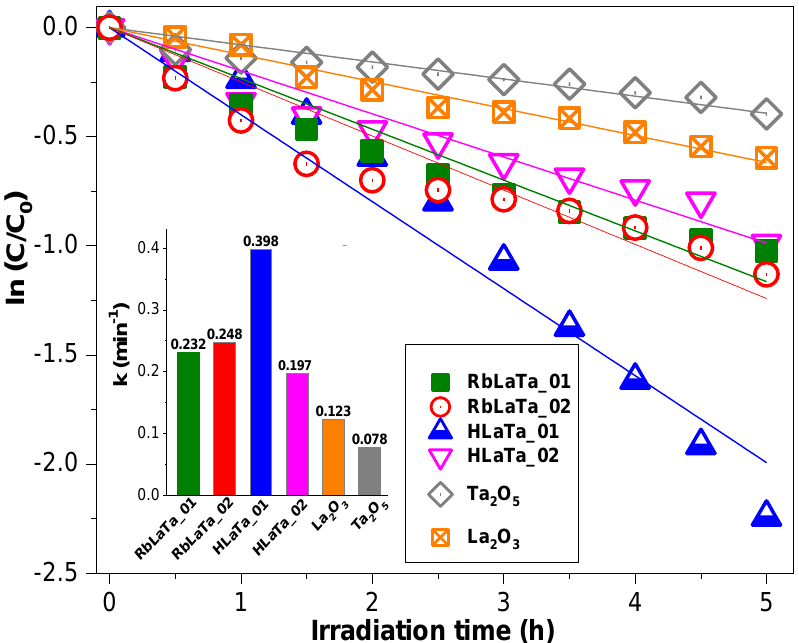
Figure 11. Pseudo-first order representation for TCE photodegradation over HLaTa_01(02) protonated layered perovskites, RbLaTa_01(02) starting materials and the commercial oxides. Insert represents the rate constant k (min −1 ).